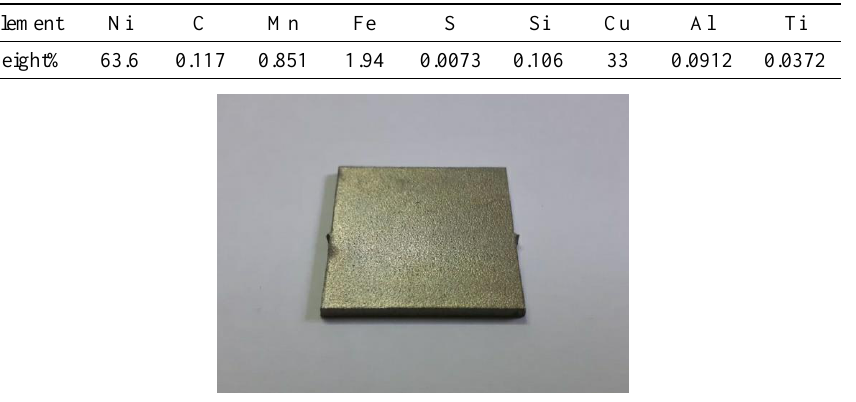
Table 1. Chemical composition of the workpiece (Monel 400).